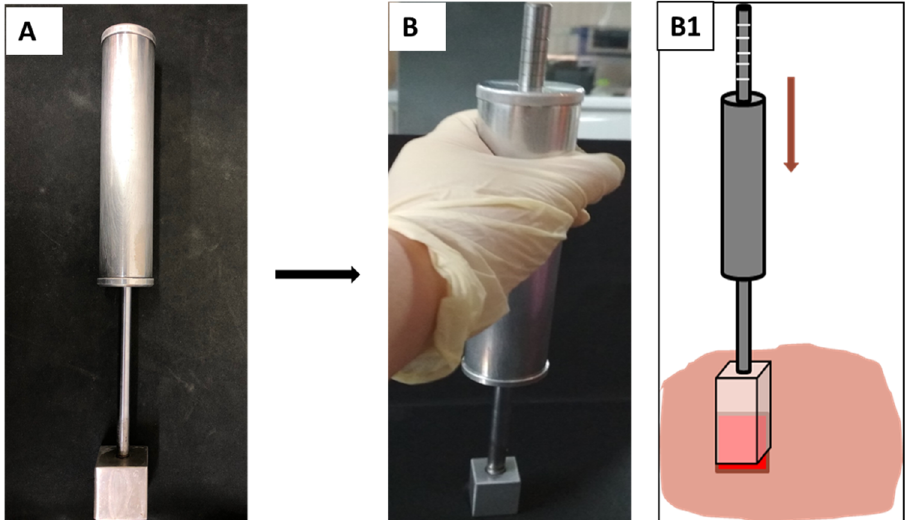
Figure 1. Pressure-controlled burn device ( A ) at normal condition and ( B ) when it is used to create burn wounds. ( B1 ) The handle moves downward and the grade lines on the stick indicate the applied force.